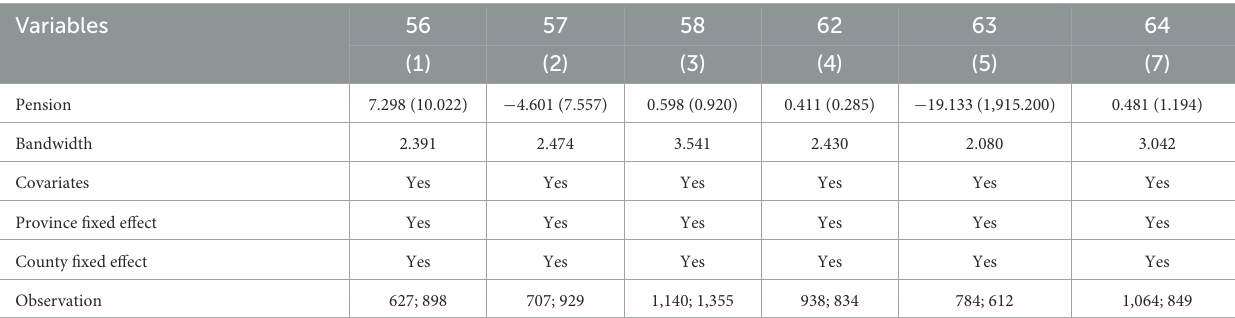
TABLE 7 Placebo tests.